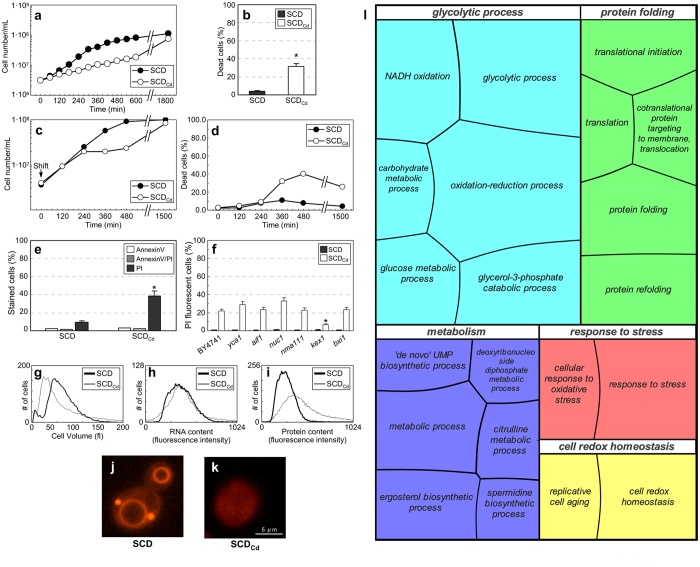
Calcium shortage affects cell growth, cell viability and vacuolar morphology.(a) W303-1A cells were grown at 30 °C in SC and SCCd liquid medium supplemented with 2% (w/v) glucose. A representative experiment out of ten performed is shown. (b) Fraction of dead cells in logarithmic phase cultures in SCD and SCDCd glucose media, as evaluated by direct microscopic examination after trypan blue staining (and confirmed by cytofluorimetric analysis). Means ± Standard Deviations (SDs) of five biological replicates are shown (n > 1000 cells; *p < 0.05, two-tailed t-test). (c,d) Cells were cultivated to log-phase in SCD medium. At time point 0, the culture was split and cells were resuspended either in SCD or SCDCd fresh media. Cellular densities of the cultures (c) and cell viability (d) are shown. A representative experiment out of three performed is shown. (e) Phosphatidylserine externalization and loss of membrane integrity in cells exponentially growing in SCD or SCDCd media detected by cytofluorimetric analysis after Annexin V/propidium iodide co-staining. Means ± SDs of three biological replicates are shown (*p <  < 0.05, two-tailed t-test). (f) Mutants defective in the apoptotic program were cultivated to late exponential phase in SCD or SCDCd media. Cell viability was evaluated by cytofluorimetric analysis. Means ± SDs of two biological replicates are shown (*p < 0.05, two-tailed t-test). (g–i) Cell volume distributions obtained by Coulter analysis (g) and protein and RNA distribution profiles obtained by cytofluorimetric analysis (h,i) for cells exponentially growing in SCD or SCDCd media. (j,k) Vacuole morphology in cells exponentially growing in SCD or SCDCd media stained with FM4-64. Representative fluorescence microscopy images are shown. (l) Comparative proteome analysis performed on cells exponentially growing in SCD or SCDCd media. Data are visualized as a treemap, in which related Gene Ontology Biological Process terms are joined into loosely related superclusters. Size of the tiles reflects the p-value.